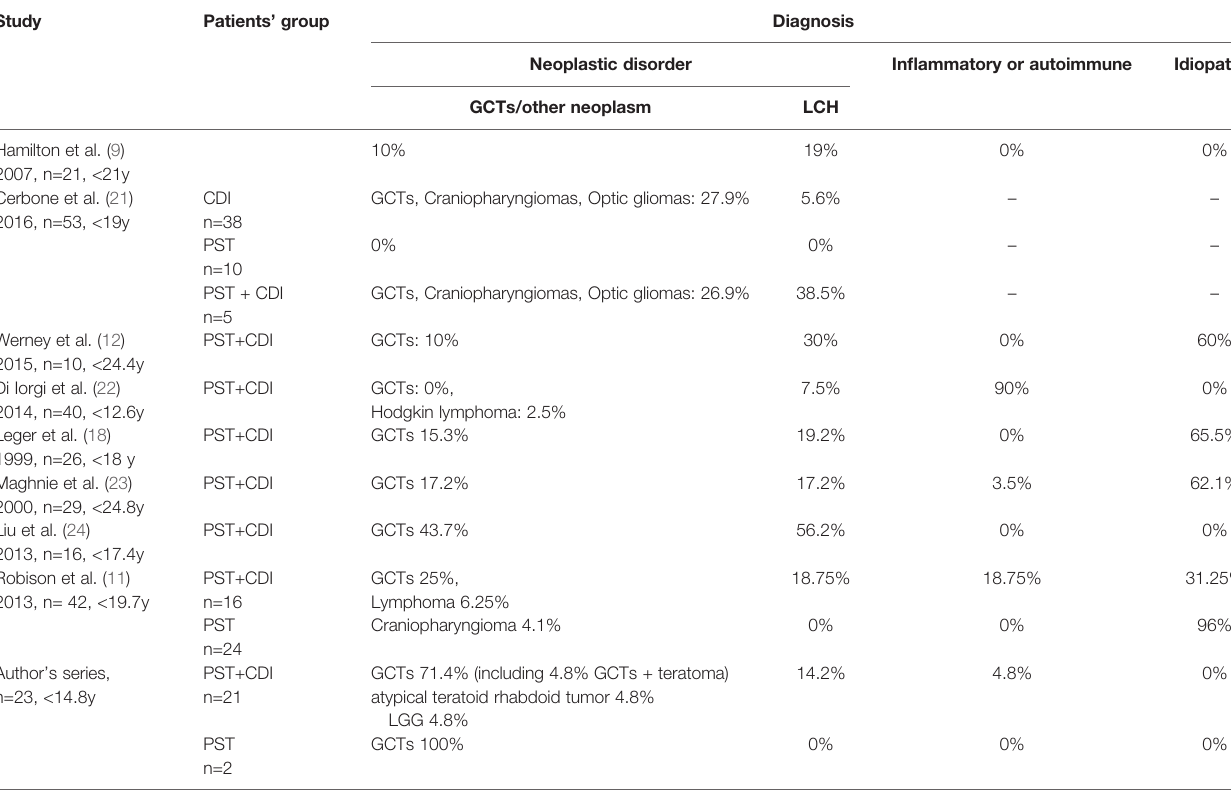
TABLE 3 | Prevalence of eventual causes responsible for PST (with/without CDI) in 8 pediatric studies and author ’ s